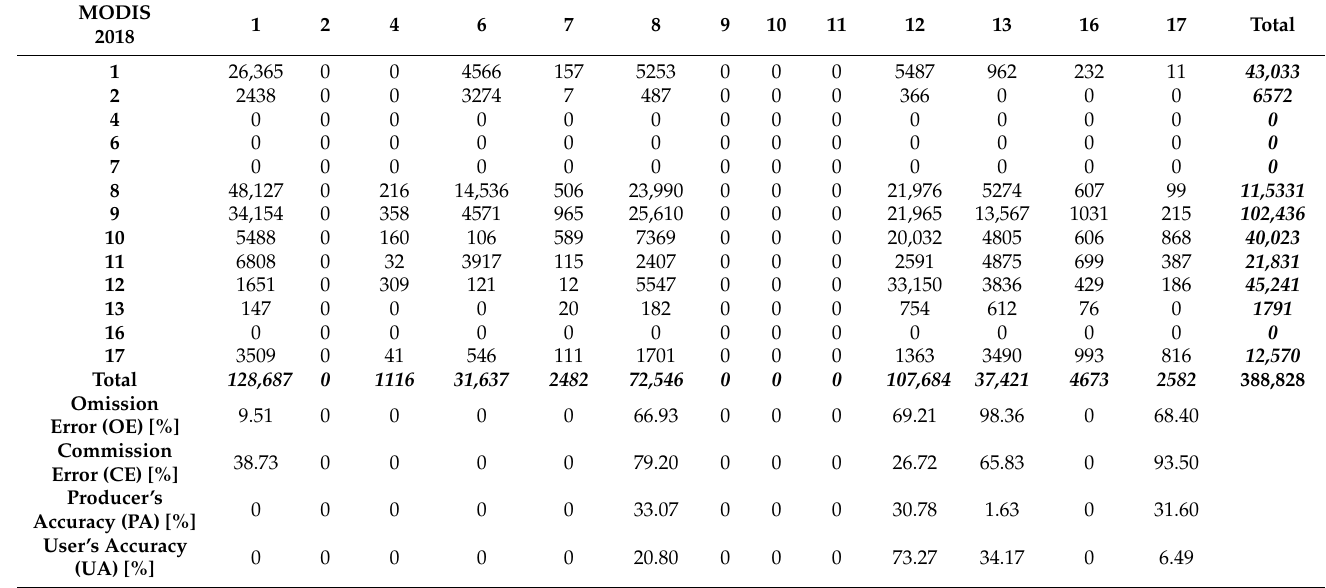
Table 6. Per-pixel error matrix showing the differences between MODIS2018 (columns) and KAS- SANDRA DATASET2018 (rows). The numbers 1–17 are MODIS